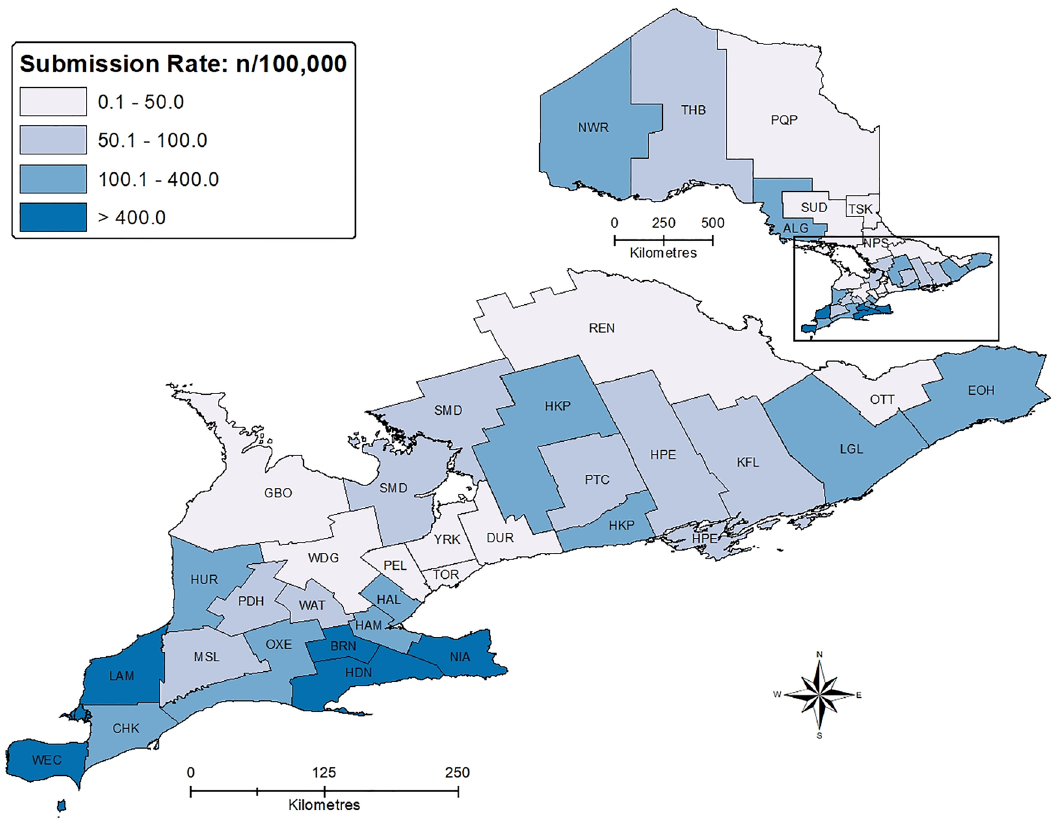
Figure 2. Dermacentor variabilis submission rates per 100,000 population, by public health unit: Ontario, Canada